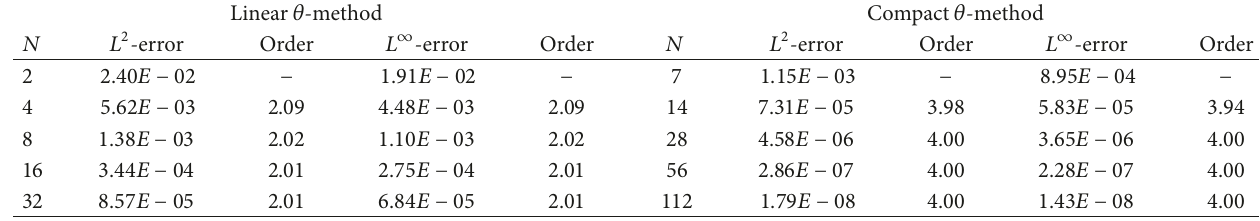
Table 2: Errors and convergence orders when 𝜃 = 0 , 𝑇 = 2 , and 𝜏 = 0.5.